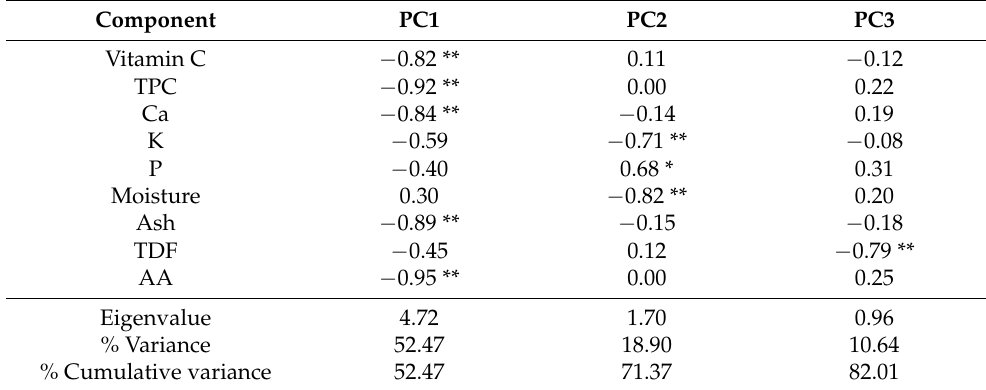
Table 2. Principal component